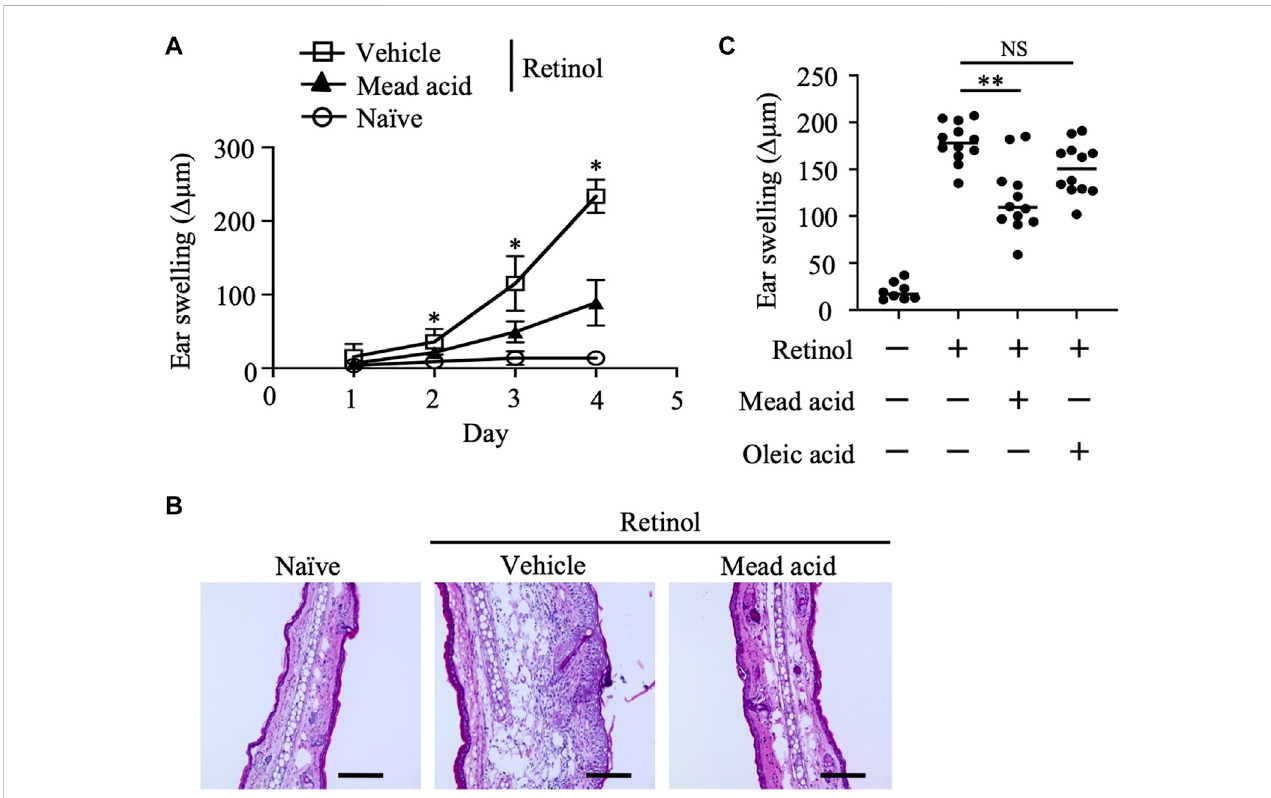
FIGURE 1 Retinol-induced irritant contact dermatitis (ICD) is inhibited by mead acid treatment. Retinol-induced ICD was induced by topical application of retinol for 4 consecutive days. Mice were treated topically with vehicle or mead acid 45 min after each retinol application. (A) Ear thickness was measured daily. Ear swelling ( Δ µm) was calculated as (Ear thickness [µm] on the indicated day) — (Ear thickness [µm] before the fi rst retinol application). n = 8/group. Data were combined from two independent experiments (mean ± SEM values). Signi fi cant differences ( p < 0.05) shown are between the vehicle and mead-acid- treatment groups. (B) For histological analysis, frozen ear sections were stained on day 5 with hematoxylin and eosin. Representative images from three independent experiments are shown. Scale bars, 100 μ m. (C) Ear thickness was measured on day 4. Ear swelling ( Δ µm) was calculated as (Ear thickness [µm] on day 4) — (Ear thickness [µm] before the fi rst retinol application). Horizontal bars indicate median values. Data are representative of three independent experiments. NS, not signi fi cant; ** p <